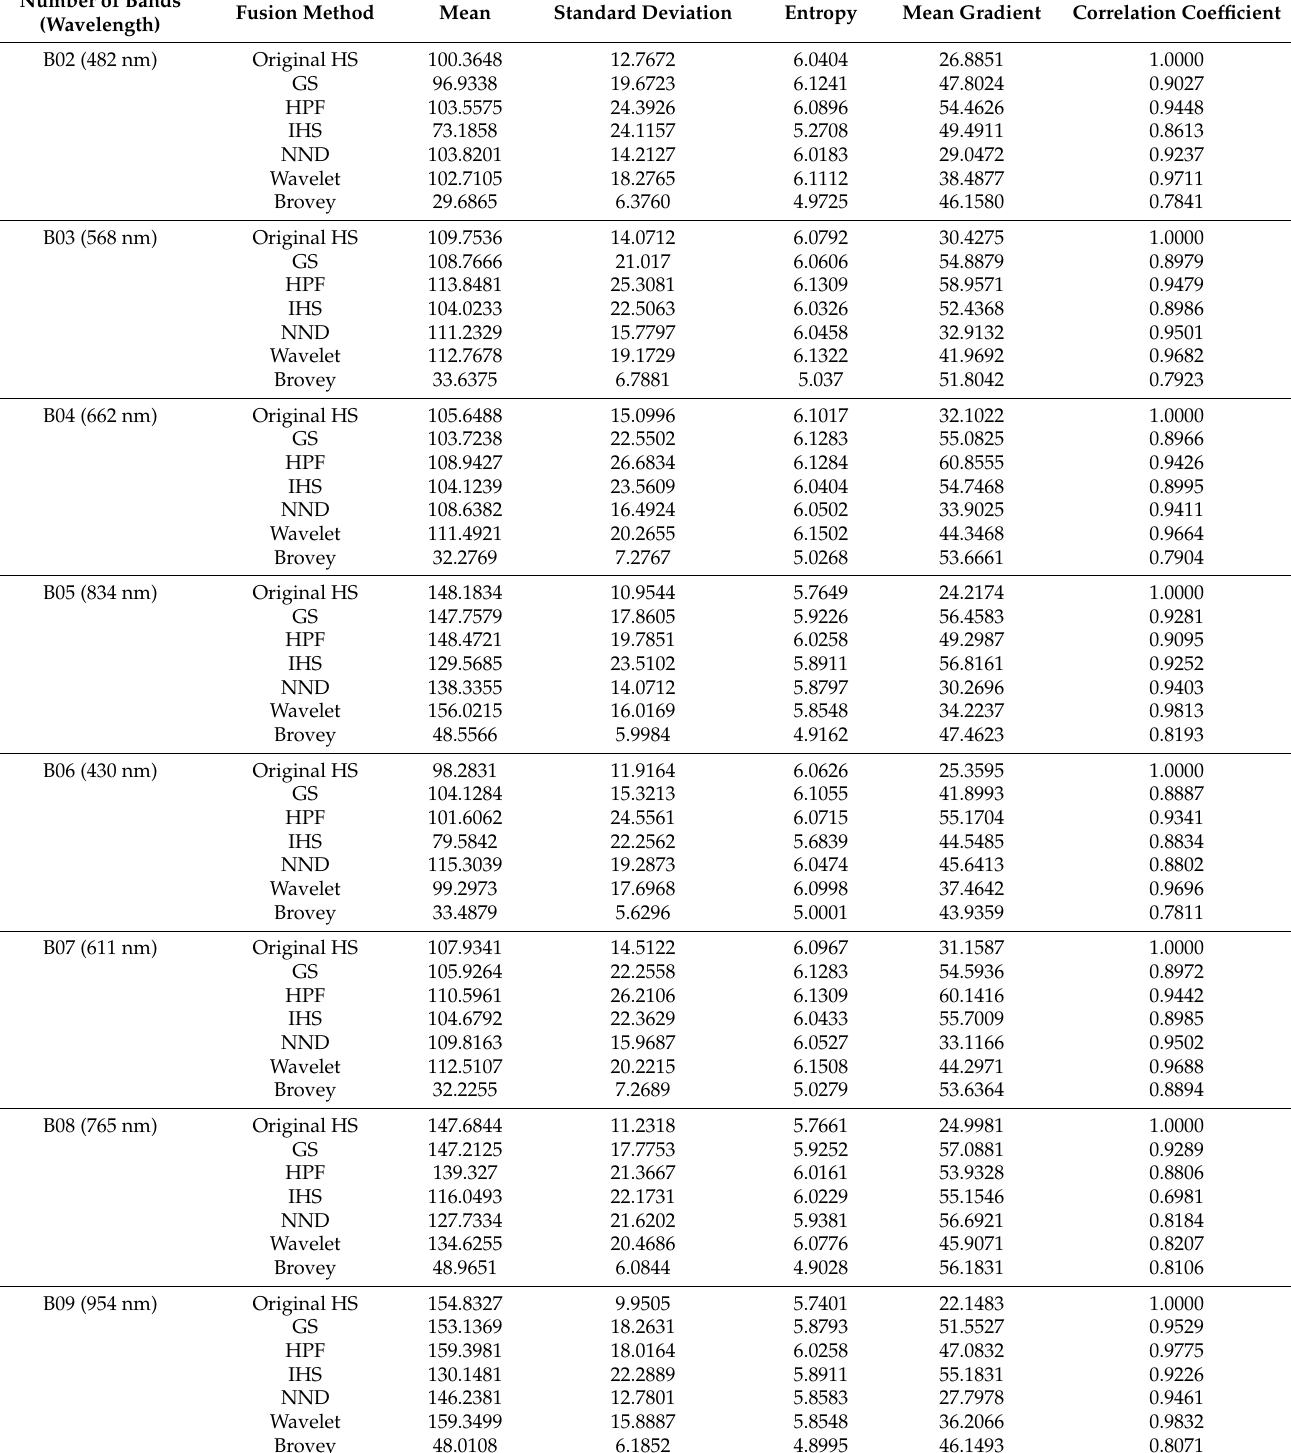
bands. Table 3 shows the mean, standard deviation, entropy, mean gradient, and correlation coefficient of the original HS image and six fused images. Table 3. Quantitative evaluation statistics